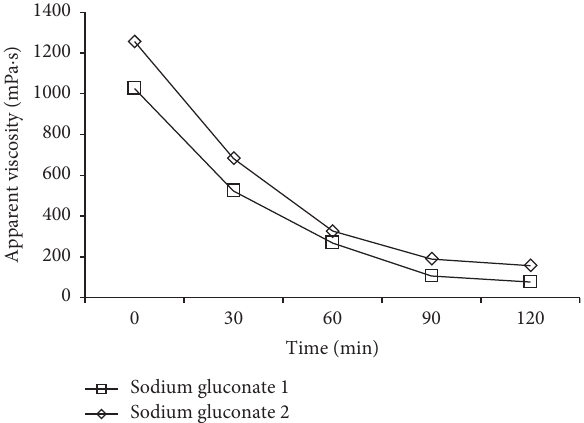
Figure 1: Apparent viscosity of the fracturing fluid using sodium gluconate 1 and sodium gluconate 2. Table 1: Characteristics of the conventional density fracturing fluid using different crosslinking ligands. Sodium gluconate